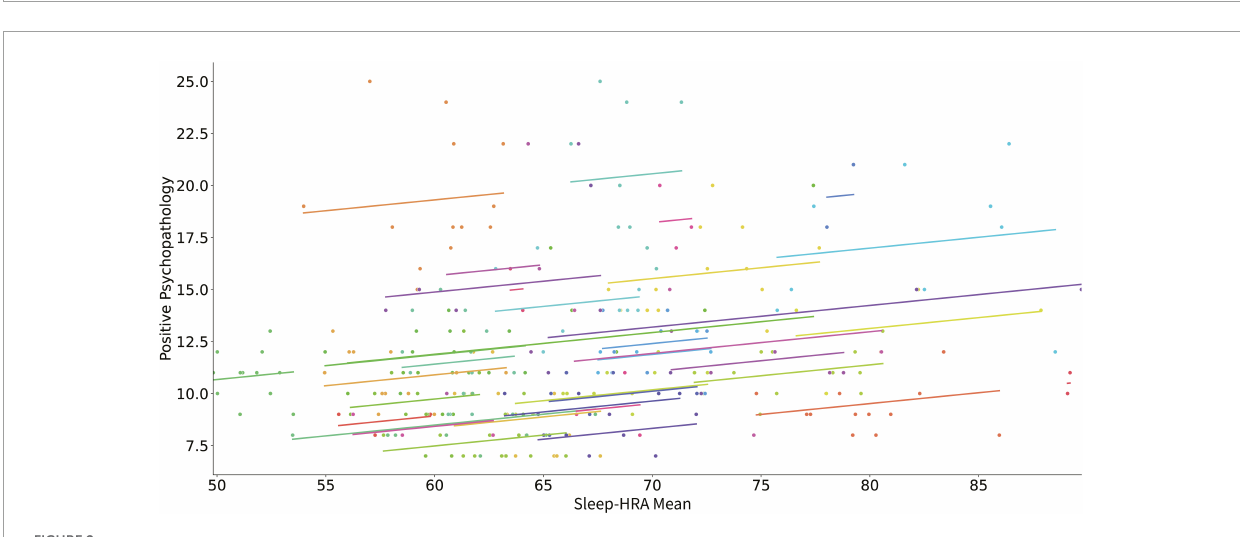
FIGURE2 Scatter plot of the relation of mean HRA during sleep and positive psychopathology (positive PANSS score). Each subject’s data as well as the predicted linear model line are presented with a different